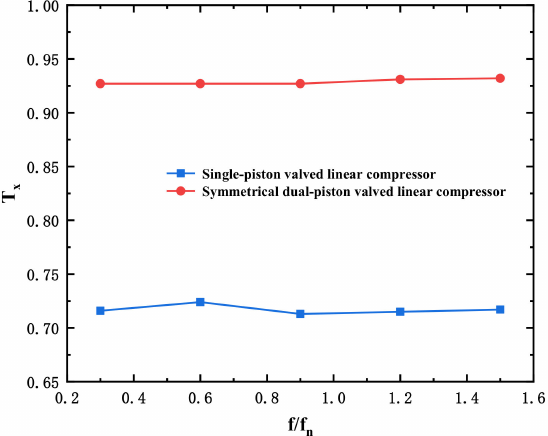
Figure 10. The same direction ratios of the two types of linear compressors under a different frequency.